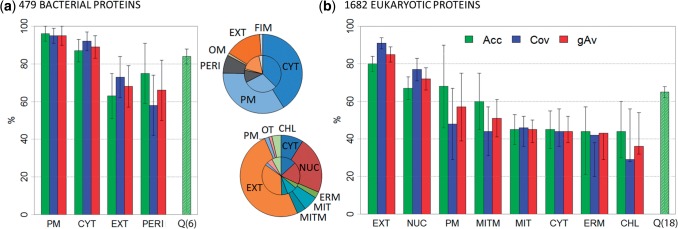
High performance in cross-validation. For the cross-validation sets (a: averages over 479 bacterial proteins and b: averages over 1682 eukaryotic proteins), LocTree2 reached high levels of sustained performance. Overall, performance tended to correlate with the number of representatives (pie charts: inner ring: composition in the corresponding data set and outer ring: composition in correct predictions). Exceptions were membrane bound classes in eukaryotes for which the performance tended to be better than that for the corresponding non-membrane bound class (e.g. MIT = mitochondrial proteins versus MITM = membrane-linked mitochondrial proteins). Localization classes as in Figure 1; performance measures: Acc, accuracy; Cov, coverage; gAv, geometric coverage of Acc and Cov; Q, overall prediction accuracy (Q6 for six and Q18 for 18 classes). Standard errors were estimated by bootstrapping (see Section 2). Classes with less than 20 members were excluded